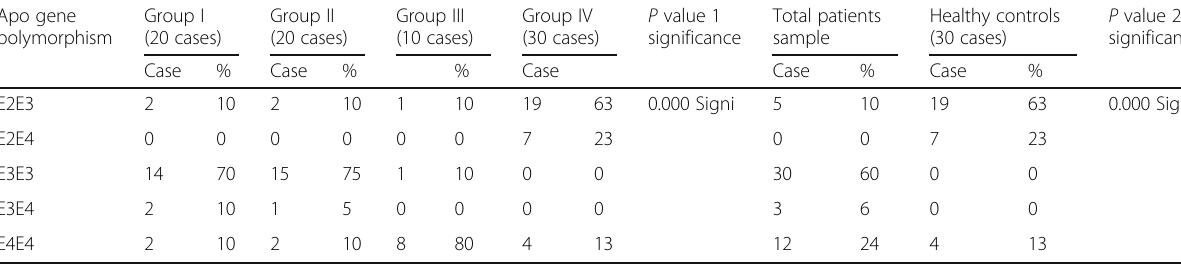
Table 8 Frequency distribution for Apolipoprotein E gene polymorphism Apo gene Group I polymorphism (20